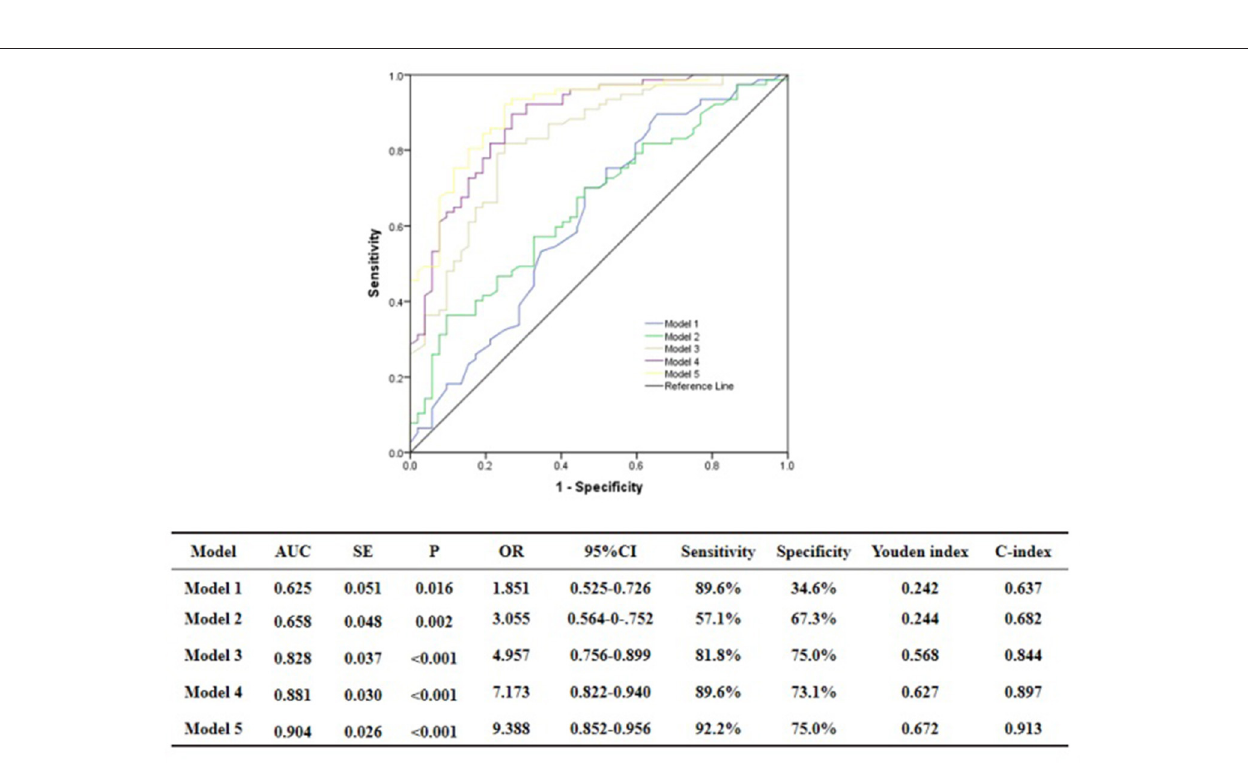
Frontiers in Cardiovascular Medicine |